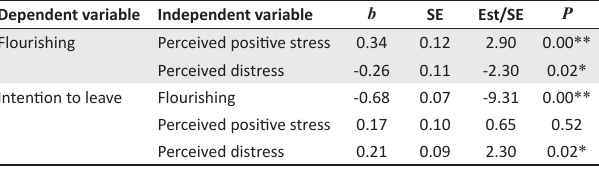
TABLE 3 : Standardised regression coefficients. Dependent variable Independent variable